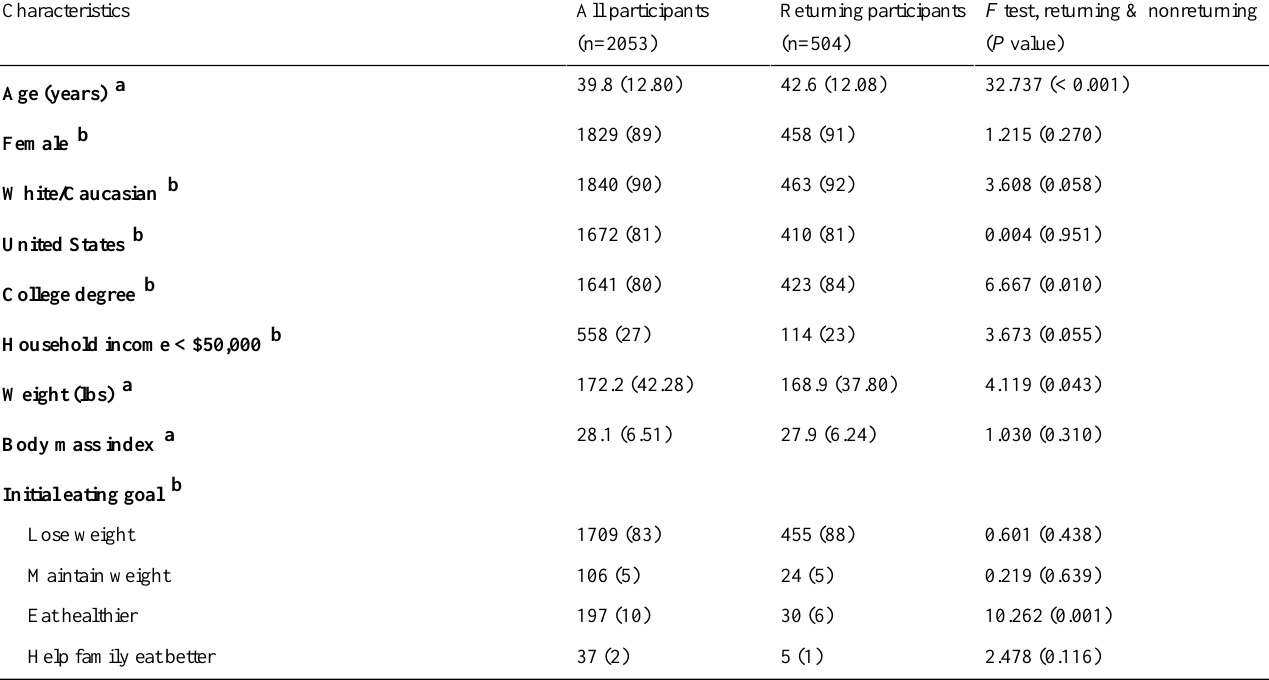
Table 1. Baseline characteristics of participants.